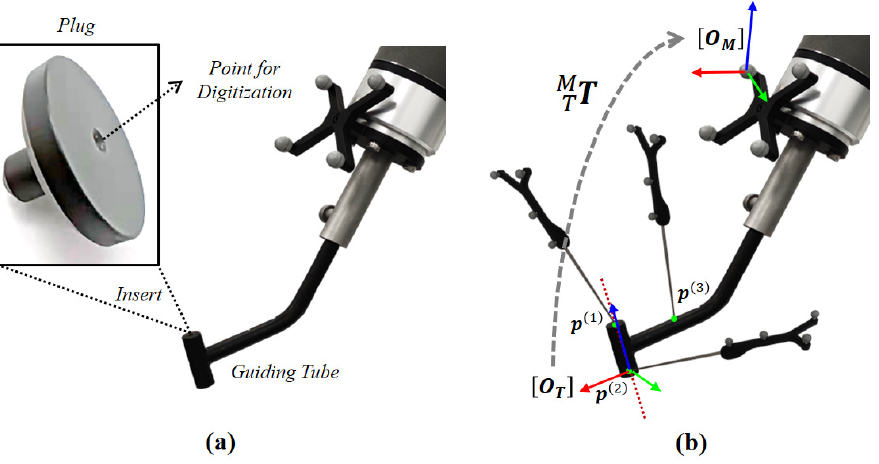
Figure 4. A schematic view the guiding tube calibration. ( a ) The plug, which can be inserted into the guiding tube from both ends for digitization. ( b ) The three points on the tube that are digitized and the COS O T of the guiding tube established using the three